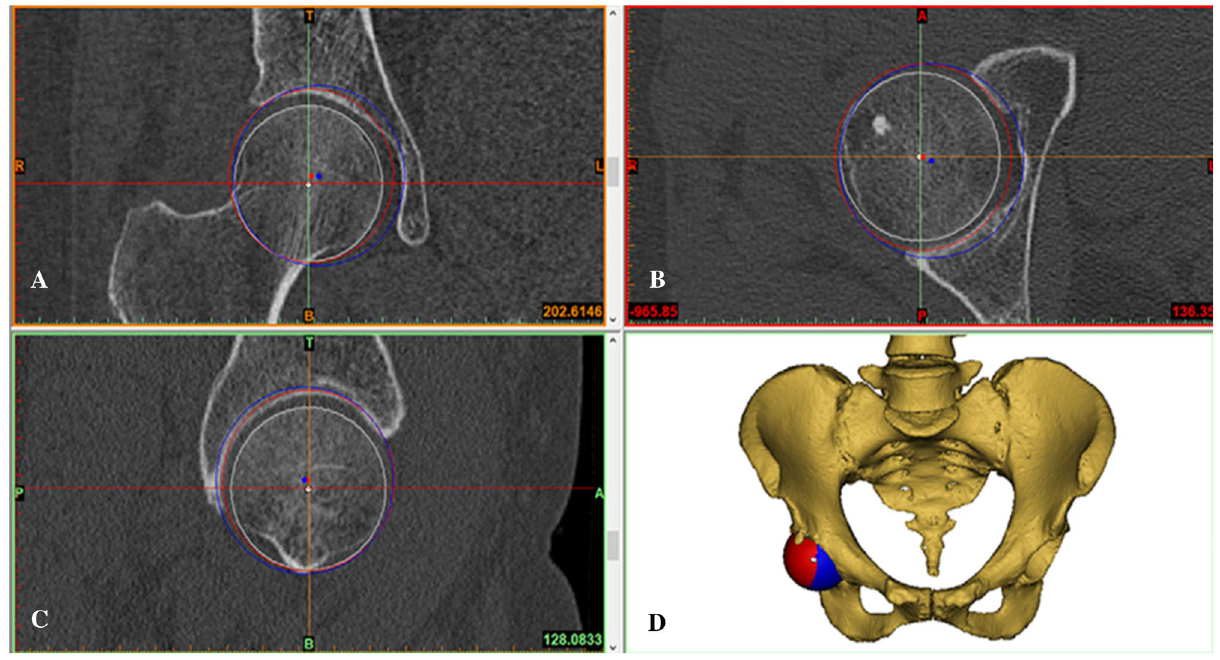
Figure 1. During the simulation of acetabular component implantation, the 3D, coronal, sagittal, and transverse views were presented simultaneously in Mimics software. Hip rotation center shift after application of the conventional reading technique and the anatomical technique in the coronal plane. The white point in the femoral head is the native hip rotation center; the blue point is the hip rotation center for conventional reaming technique; the red point is the hip rotation center for the anatomical technique. Medial shift and superior shift were determined by measuring the coronal and vertical distances from the blue and red points to the white point, respectively ( A ). ( B – D ). The axial plane ( B ), the sagittal plane ( C ), and the 3D model of the mimic implantation ( D